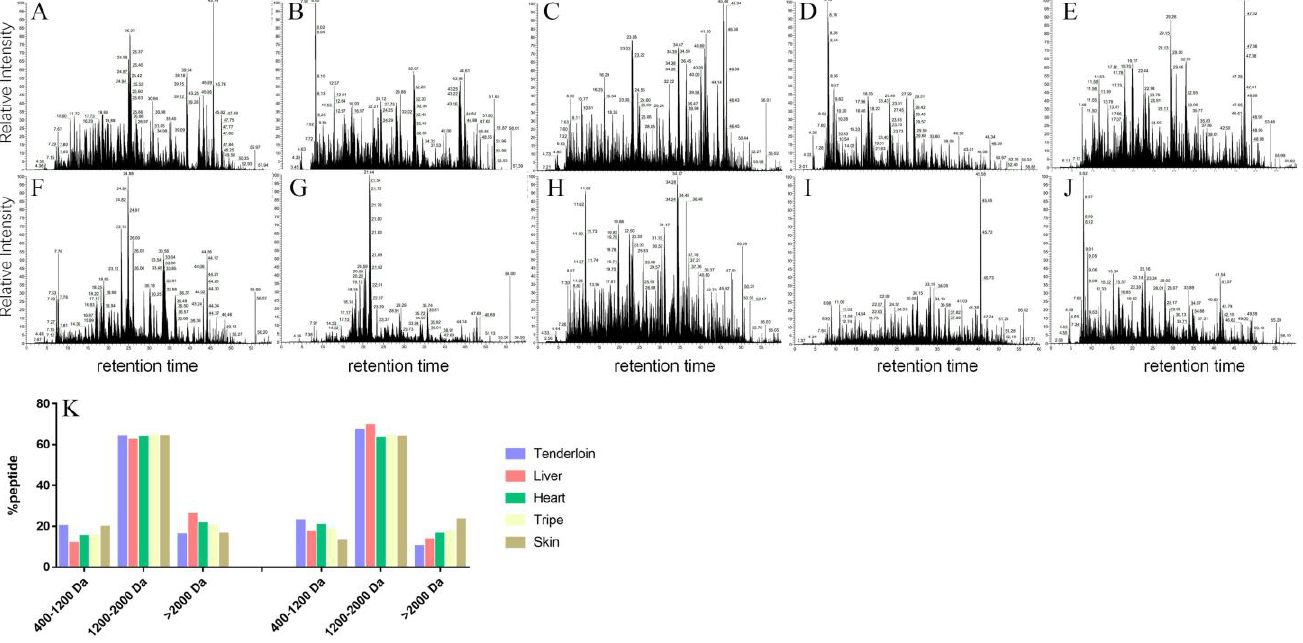
Figure 3. Comparison of the peptide compositions of tenderloin and edible pork by-product after the in vitro gastric and gastrointestinal digestion. ( A – E ) indicate the total ions chromatograms for the gastric digests of cooked pork tenderloin, liver, heart, tripe and skin, respectively; ( F – J ) indicate the total ions chromatograms for the gastrointestinal digests of cooked pork tenderloin, liver, heart, tripe and skin, respectively; ( K ) indicates the molecular distribution of gastric or gastrointestinal digests. Small peptides are more efficiently absorbed in small intestines than free amino acid mixtures, whereas the absorption of bigger peptides is uncertain [24]. The molecular weight distribution of peptides of each sample after gastric and the whole gastrointestinal digestion were compared in Figure 3K. After the simulated gastric digestion, higher per- centage of peptides in the molecule range 400 – 1200 Da were identified in the digests of tenderloin and skin than others, corresponding to the higher level of liberated – NH 2 in these two samples. After the whole gastrointestinal digestion, higher percentages of pep- tides in the molecule range >2000 Da were found in the digests of liver and skin, whereas higher percentages of smaller peptides (<1200 Da) were found in the digests of tenderloin and heart. These peptidomics results were also in line with the results of liberated – NH 2 , SDS-PAGE and CLSM images in previous sections, even though some small peptides were not considered due to the limitation of peptidomic algorithm [25]. Collagen is a ma- jor protein in skin. Some collagen is quite resistant to digestion because it has a complex triple helix structure and much higher percent of glycine and (hydroxyl) proline contrib- uting to a tightly tertiary structure [26,27]. In addition, collagen has lower level of Trp, which are crucial action sites for both pepsin and chymotrypsin [28,29]. These account for the lower ratio of smaller peptides and larger ratio of bigger peptides in the digests of skin. Bioactive probabilities of the peptide with top 100 LFQ intensity in gastrointestinal digest were calculated, and the result was shown in Table S1. Interestingly, the highest average bioactive probability was identified in the digests of liver (0.386), which was fol- lowed by the digests of tripe (0.385), tenderloin (0.336), skin (0.263) and heart (0.262). In this work, all tested edible pork by-products were found to have lower digestibil- ity than tenderloin, possibly due to the higher level of Pro, connective tissues, different protein composition or different muscle structures. High pressure, ultrasound treatment was reported to largely collapse the microstructures of muscle and connected tissues,